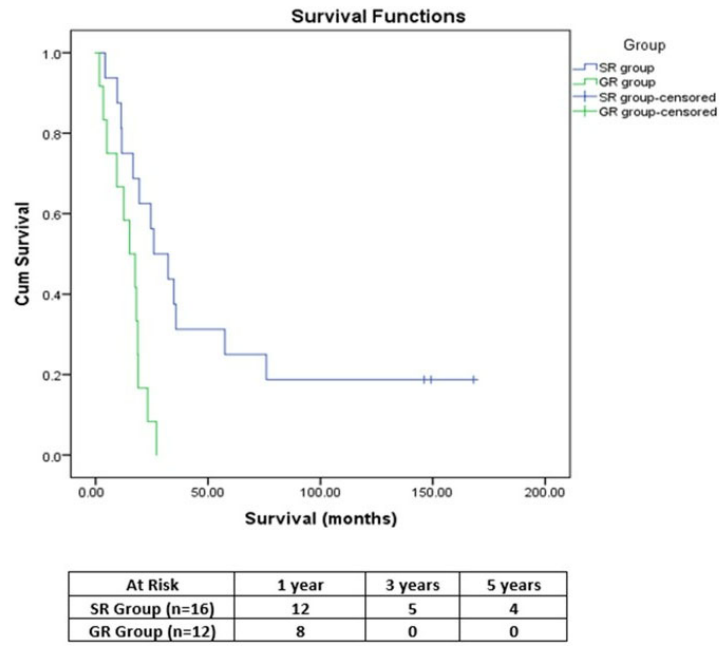
Figure 1. Comparative OS curves (SR group vs. GR group).